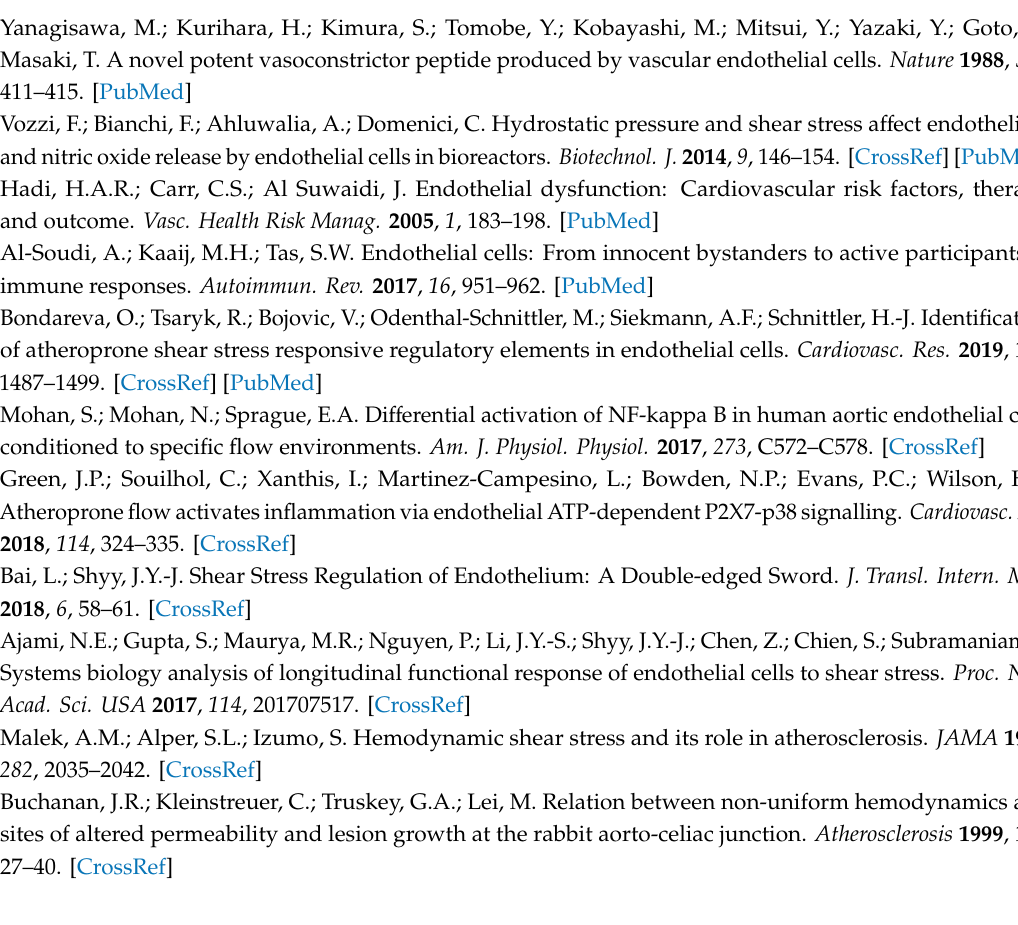
shakers with an orbit size of 10, 19 or 25 mm. The graphical representation scales from 0 to 2.0 Pa to cover shear stress distributions for both high and low rotational speeds. Figure S3: Shear distribution in the 134 / 56 and 134 / 89 annular dish in response to orbital speed. Heat maps of the shear stress distribution in the 134 / 56 (10 mm orbit) and 134 / 89 (19 mm orbit) annular dish on orbital shakers, swirled at an orbital speed of 100, 125, 150 and 200 rpm. The graphical representation scales from 0 to 1.0 Pa to cover shear stress distributions for both high and low rotational speeds. Figure S4: Shear distribution in the 134 / 56 and 134 / 89 annular dish in response to fluid height. Shear stress distribution heat maps in the 134 / 56 (10 mm orbit) and 134 / 89 (19 mm orbit) annular dish on the orbital shaker with a starting medium height of 2, 3 or 4 mm culture medium. The graphical representation scales from 0 to 1.0 Pa to cover shear stress distributions for both high and low rotational speeds. Figure S5: Endothelial alignment in the annular dish. (A) Graphical representation of the net shear stress vector in a 134 / 56 annular dish at 200 rpm, 10 mm orbit, and 3 mm fluid level. (B) Representative widefield images of ECs at di ff erent positions in a 134 / 56 annular dish after a 24-h culture period under flow. The ECs align in the direction of the net flow direction. (C) Quantification of the cellular alignment. (D) The main shear stress direction is shown as a function of the radial position in the annular dish. The dashed line at 90 degrees indicates the orbital direction. Table S1: Primers used in gene expression